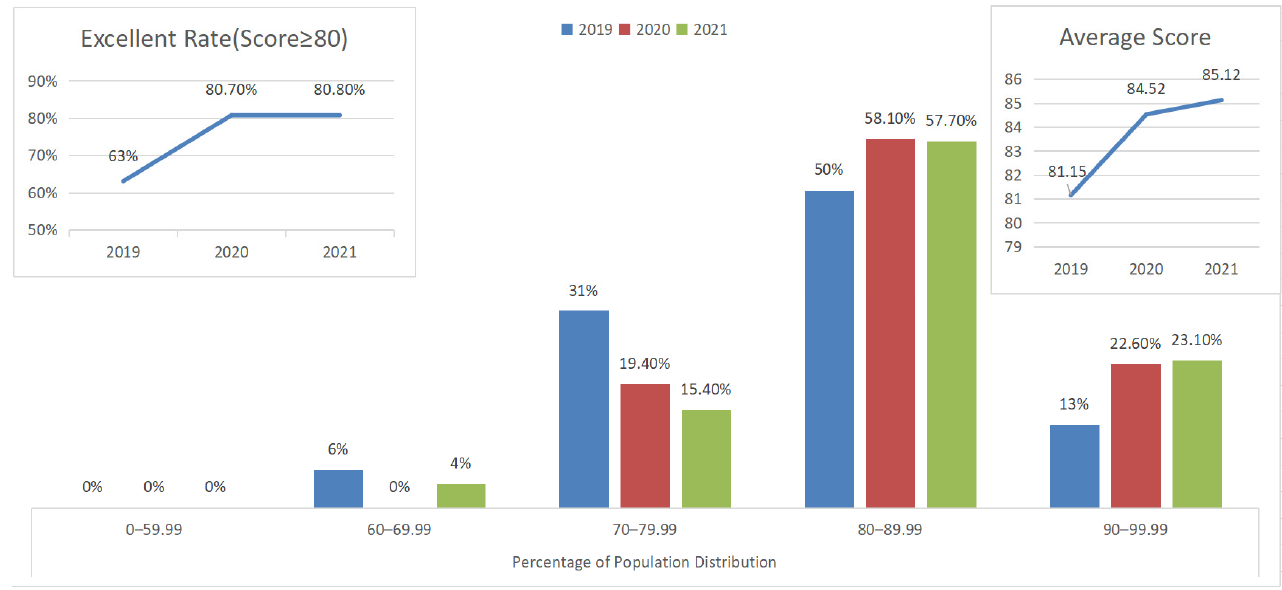
Figure 23. Analysis and statistics of students’ scores in integrated circuit course.